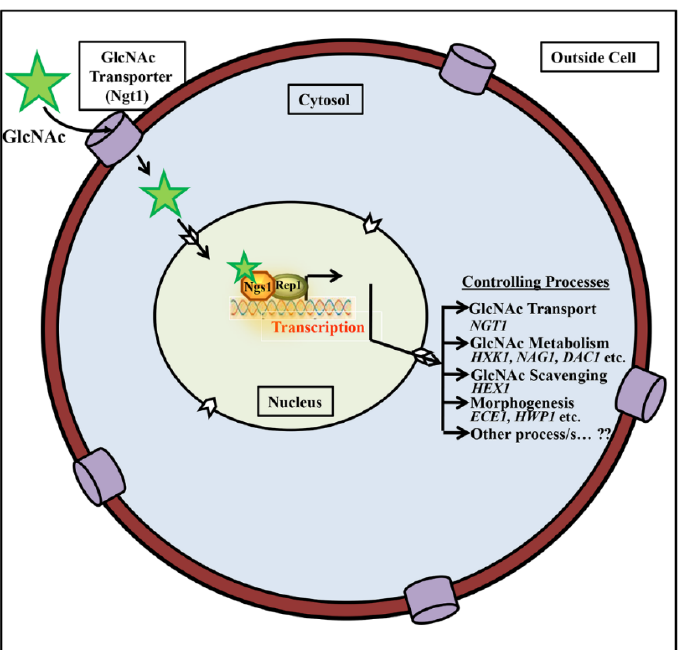
Figure 2. Working model for GlcNAc import and its signaling in C. albicans . Exogenous GlcNAc is imported into cytosol through GlcNAc specific transporter, Ngt1. In the nucleus GlcNAc binds to GlcNAc sensor, Ngs1 to activate transcription of genes involved in various processes (37) as shown in the figure. Transcription factors, such as Rep1, which bind to DNA, recruit GlcNAc sensor Ngs1 at cognate gene promoters and transduce GlcNAc signaling. Ngs1 acts as a master regulator of GlcNAc signaling by regulating various cellular processes, such as GlcNAc transport ( NGT1 ), GlcNAc metabolism ( HXK1 , NAG1 , DAC1 etc.), GlcNAc scavenging ( HEX1 ), morphogenesis ( HWP1 , ECE1 etc.), and other uncharacterized